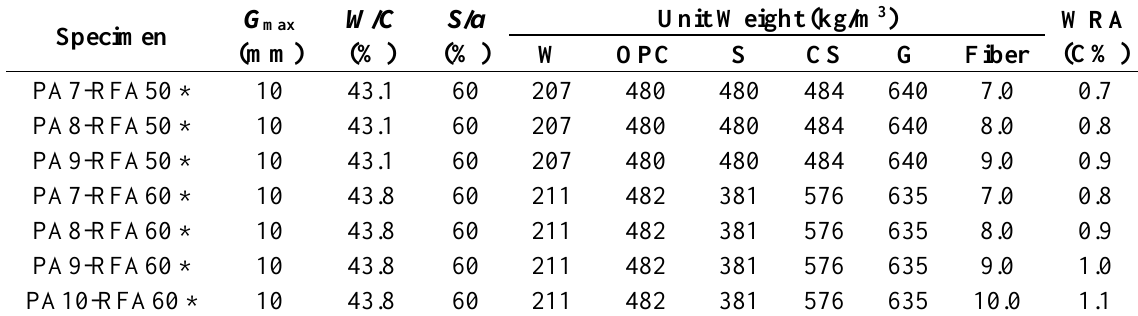
* RFA xx: ratio of recycled fine aggregate to fine aggregate. Table 3. PAFRC slump and compressive